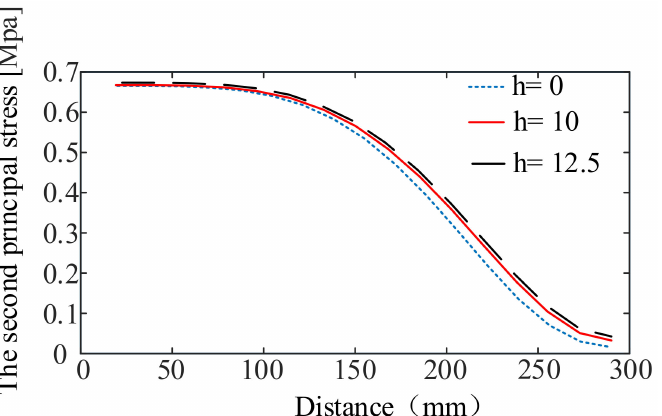
Figure 11. The second principal stress distribution on the straight line from the center of the mem- brane to the center of the arc